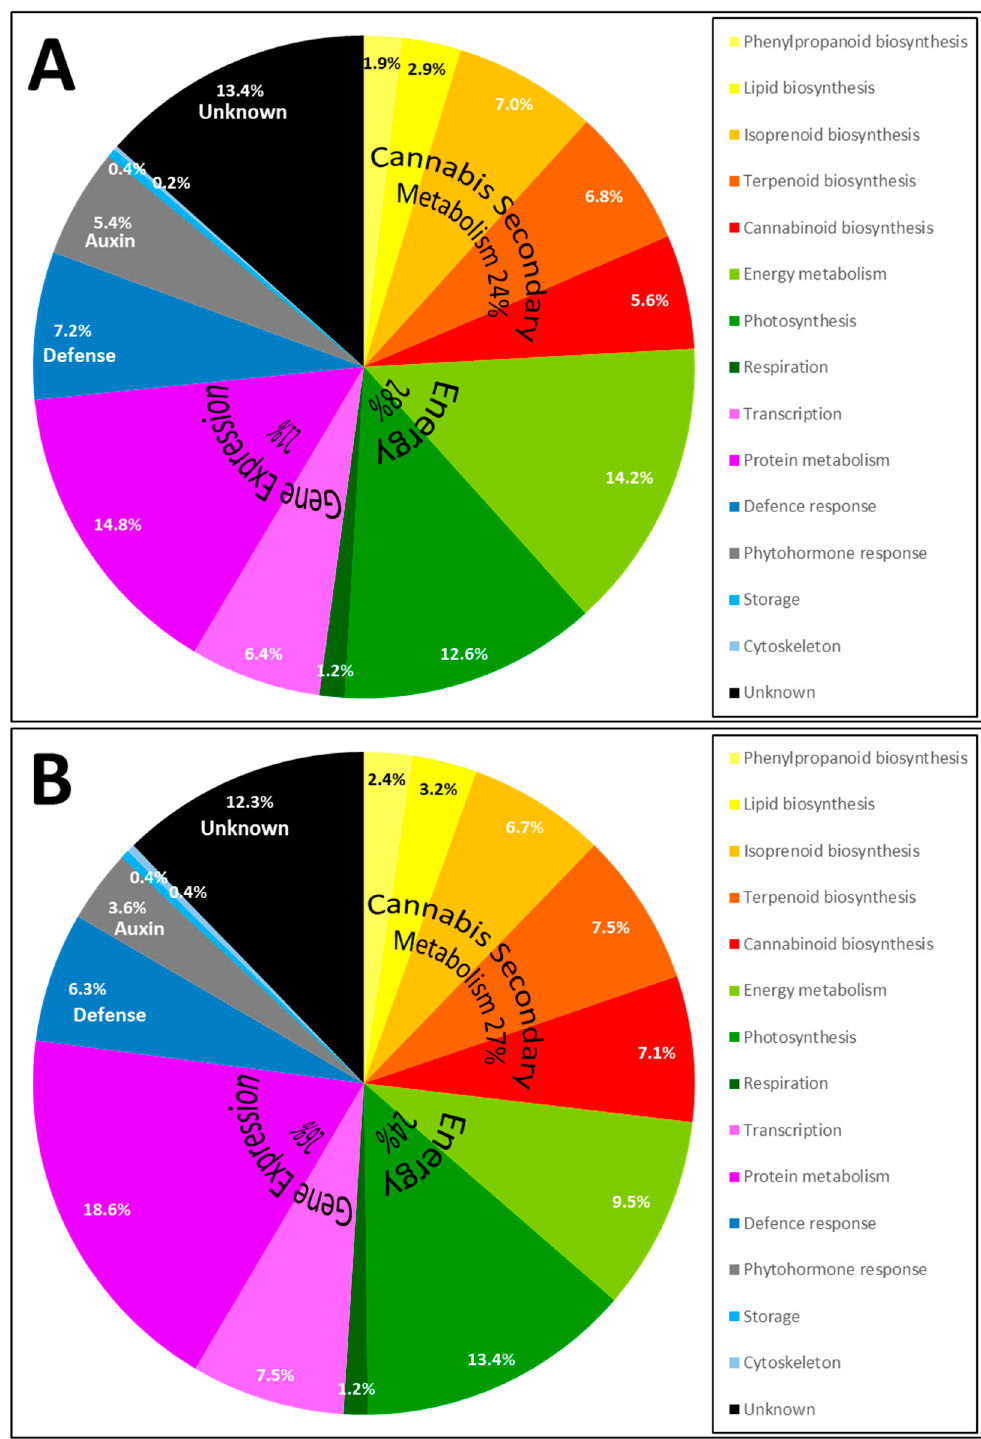
Figure 5. Pie chart of the pathways in which identified Cannabis proteins are involved in and recovered from apical buds ( A ) and trichomes ( B ).